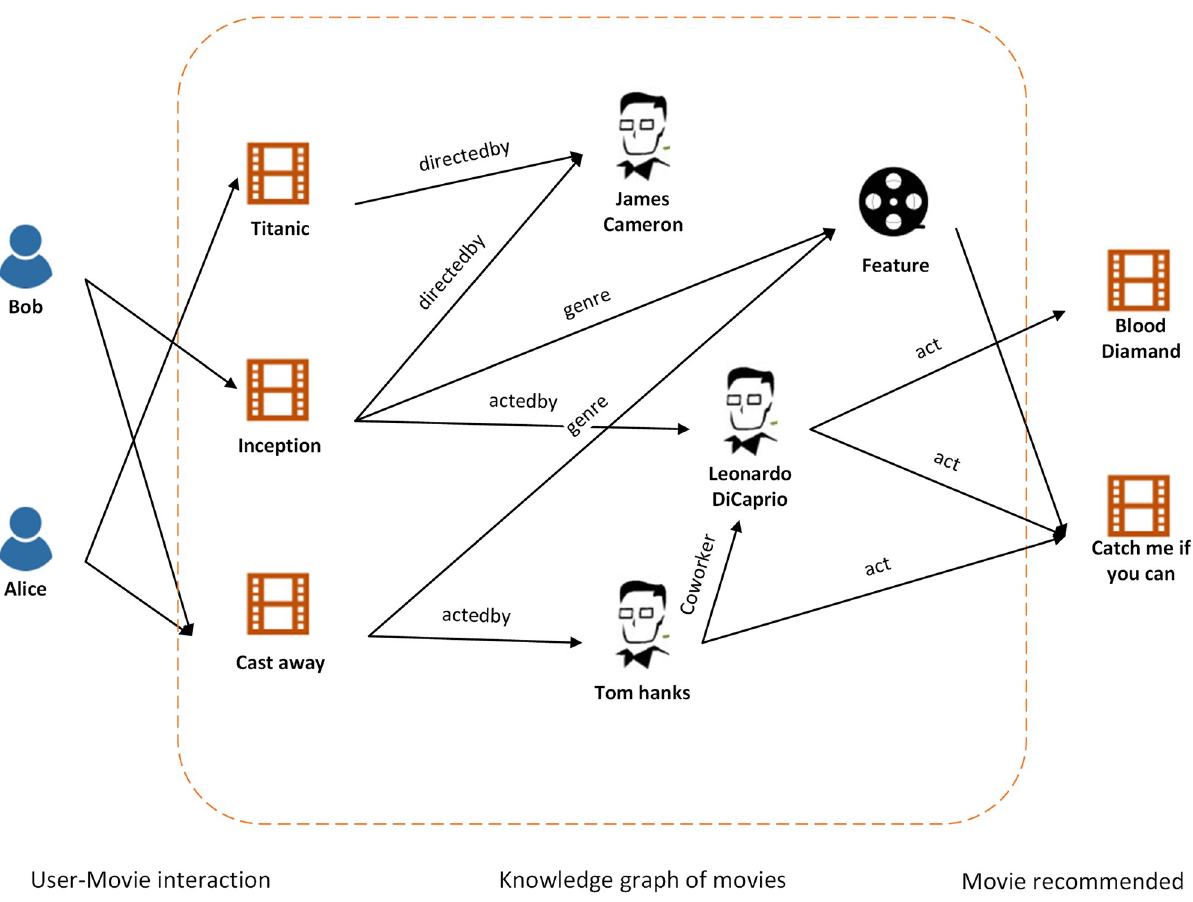
Fig 1. An illustration of knowledge graph enhanced recommendation system. The relations between items are annotated with different semantic meanings and the knowledge graph provides detailed facts about movies and their attributes.